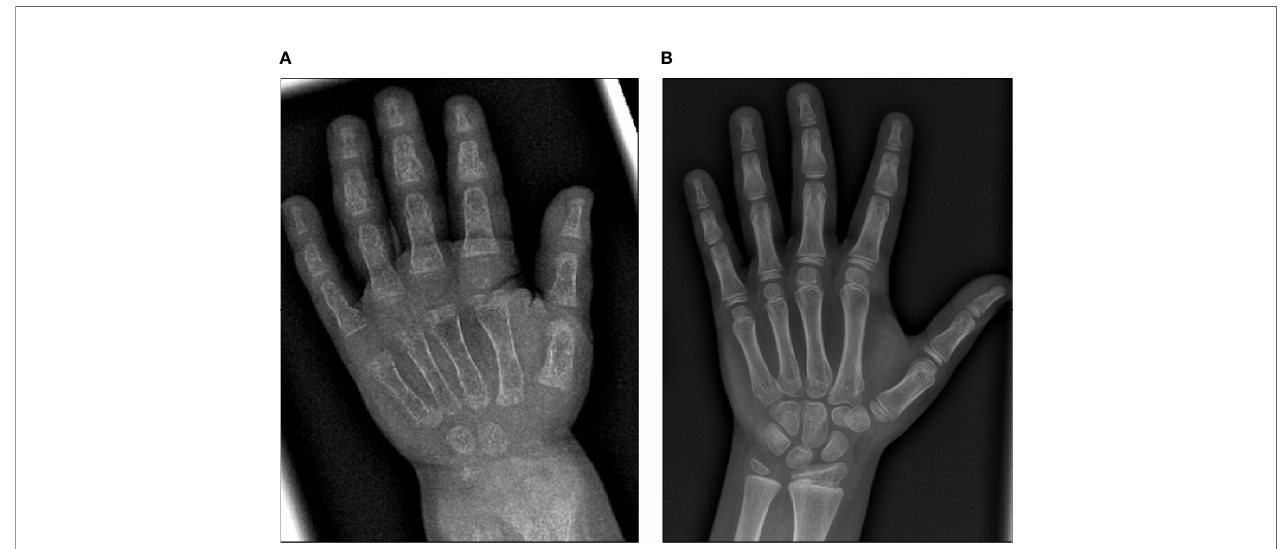
FIGURE 3 | X-ray images of the left hand before and after 42 months of burosumab treatment. (A) X-ray image of the left hand at 3.5 years of age. Note gracile, undermineralized bone structure with loss of de fi nition of the provisional calci fi cation zone at the epiphyseal/metaphyseal interface and disorganization of the growth plate. Bone age was determined to be 1 year. (B) Follow-up X-ray image of the left hand at 8 years of age. According to the RGI-C score, a substantial improvement in ricket severity (RGI-C score +2) is noted. Overall skeletal maturity with a nearly age-appropriate bone age of 7.5 years was